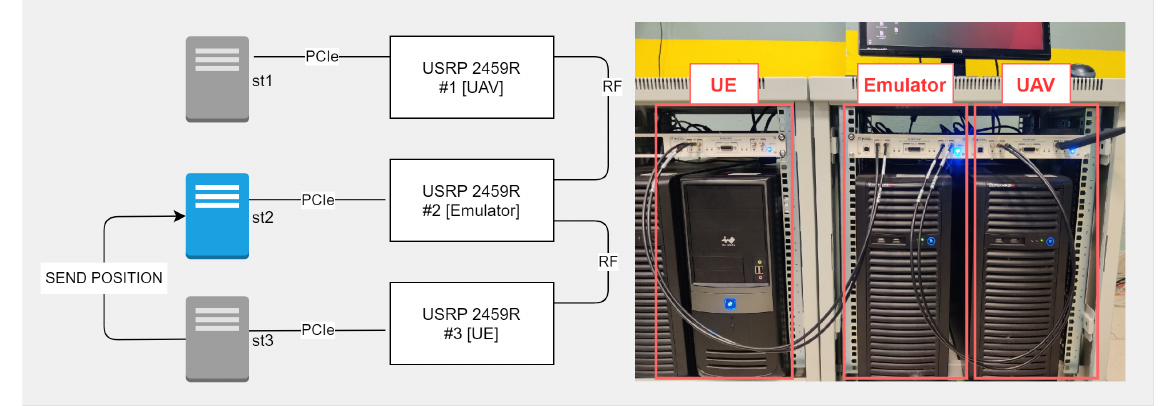
Figure 6. Testbed picture UAV-UE connection. (OFDMA 3500 MHz, QAM 256, bandwidth 40